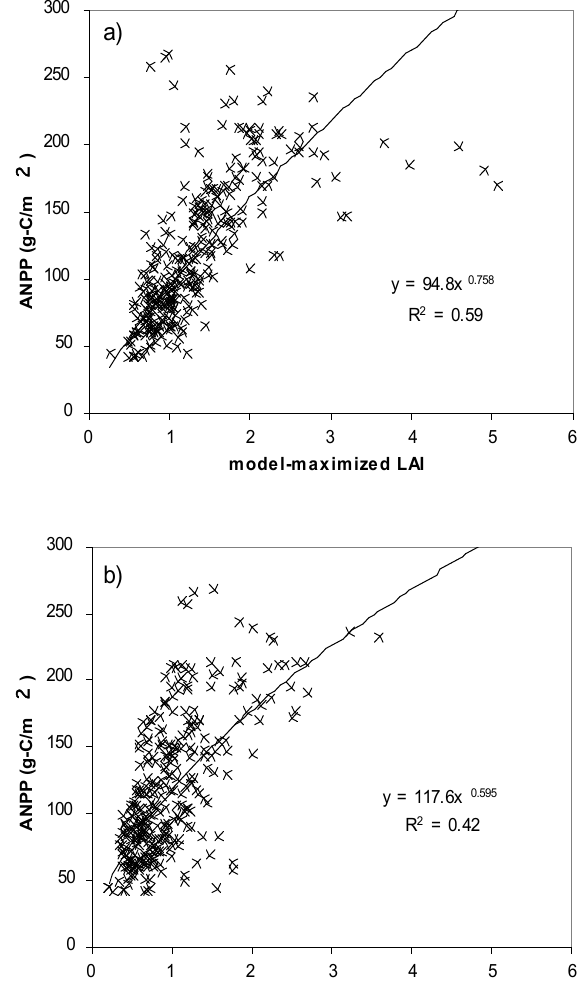
Fig. 9. Comparison of the estimates of grassland ANPP from Zheng et al. (2003) based on Tieszen et al. (1997) with: (a) modeled- determined peak green LAI, and (b) unaltered NDVI-based obser- vations of peak green LAI (Buerman et al.,